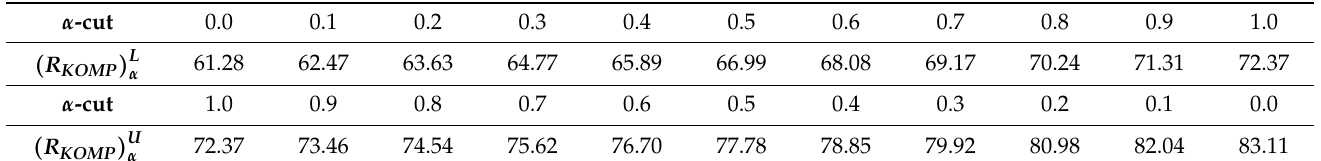
Table 9. The average of all combinations—the final fuzzy value of the superstructure component rating.